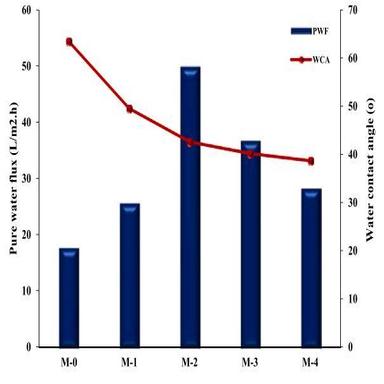
Initial pure water flux and water contact angle of the fabricated photocatalytic membrane.